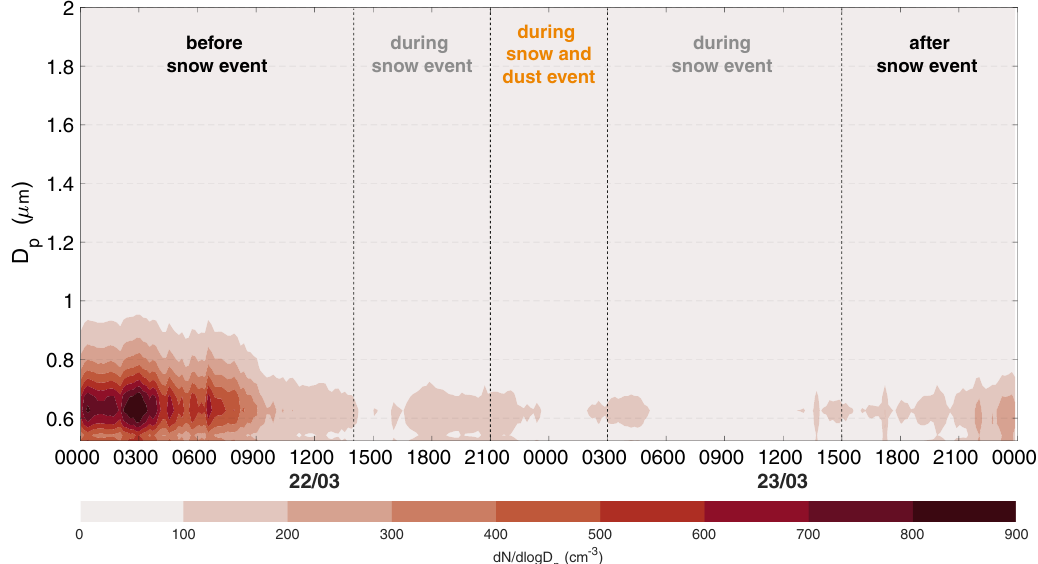
Figure 7. The evolution between 22 March 0000 UTC–24 March 0000 UTC of the aerosol size distribution obtained from Aerodynamic Particle Sizer